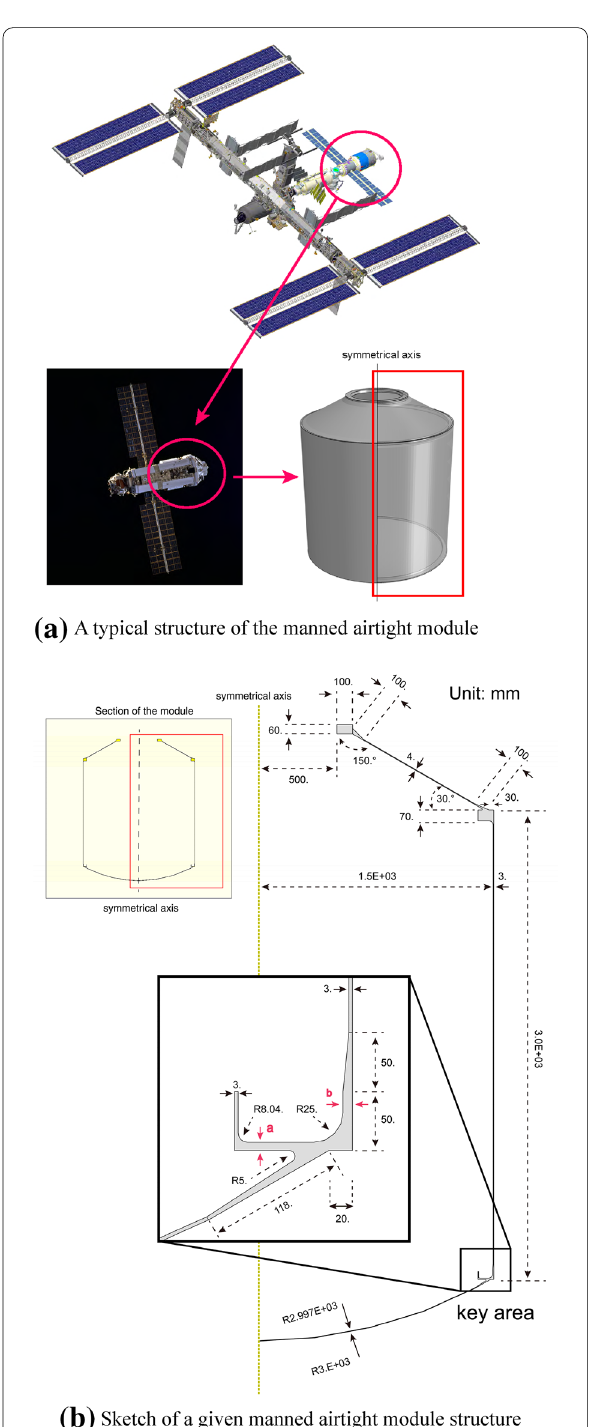
Figure 5 A typical structure of the airtight module from manned spacecraft and its